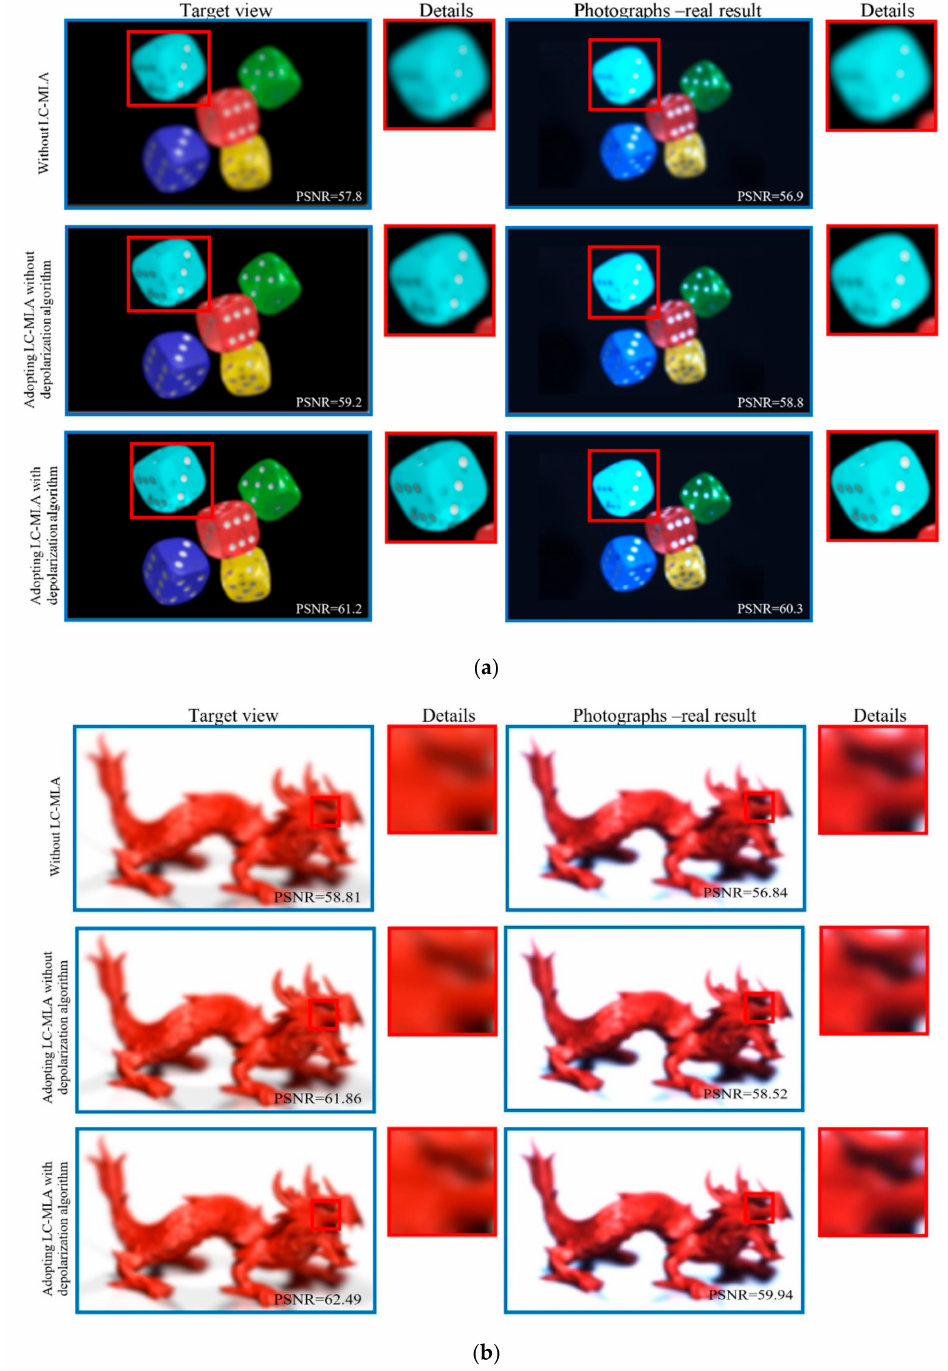
Figure 6. Comparative experiment results of light field display with PDLC film. ( a ) The “Dices” with 25 ◦ × 25 ◦ ; ( b ) The “Dragon” with 25 ◦ × 25 ◦